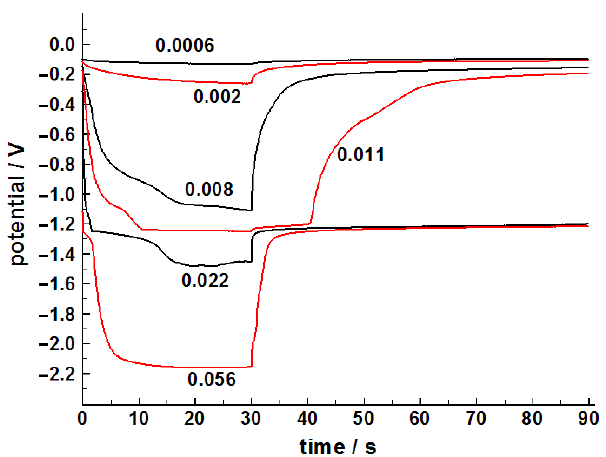
Figure 3. Examples of chronopotentiograms recorded during cathodic polarization of tungsten electrode in 3LiCl–2KCl–UCl 3 melts (1.14 wt. % U, 546 °C). Polarization current density (A/cm 2 ) is given on the graph for each set of data. Potentials vs. Ag/AgCl reference electrode.